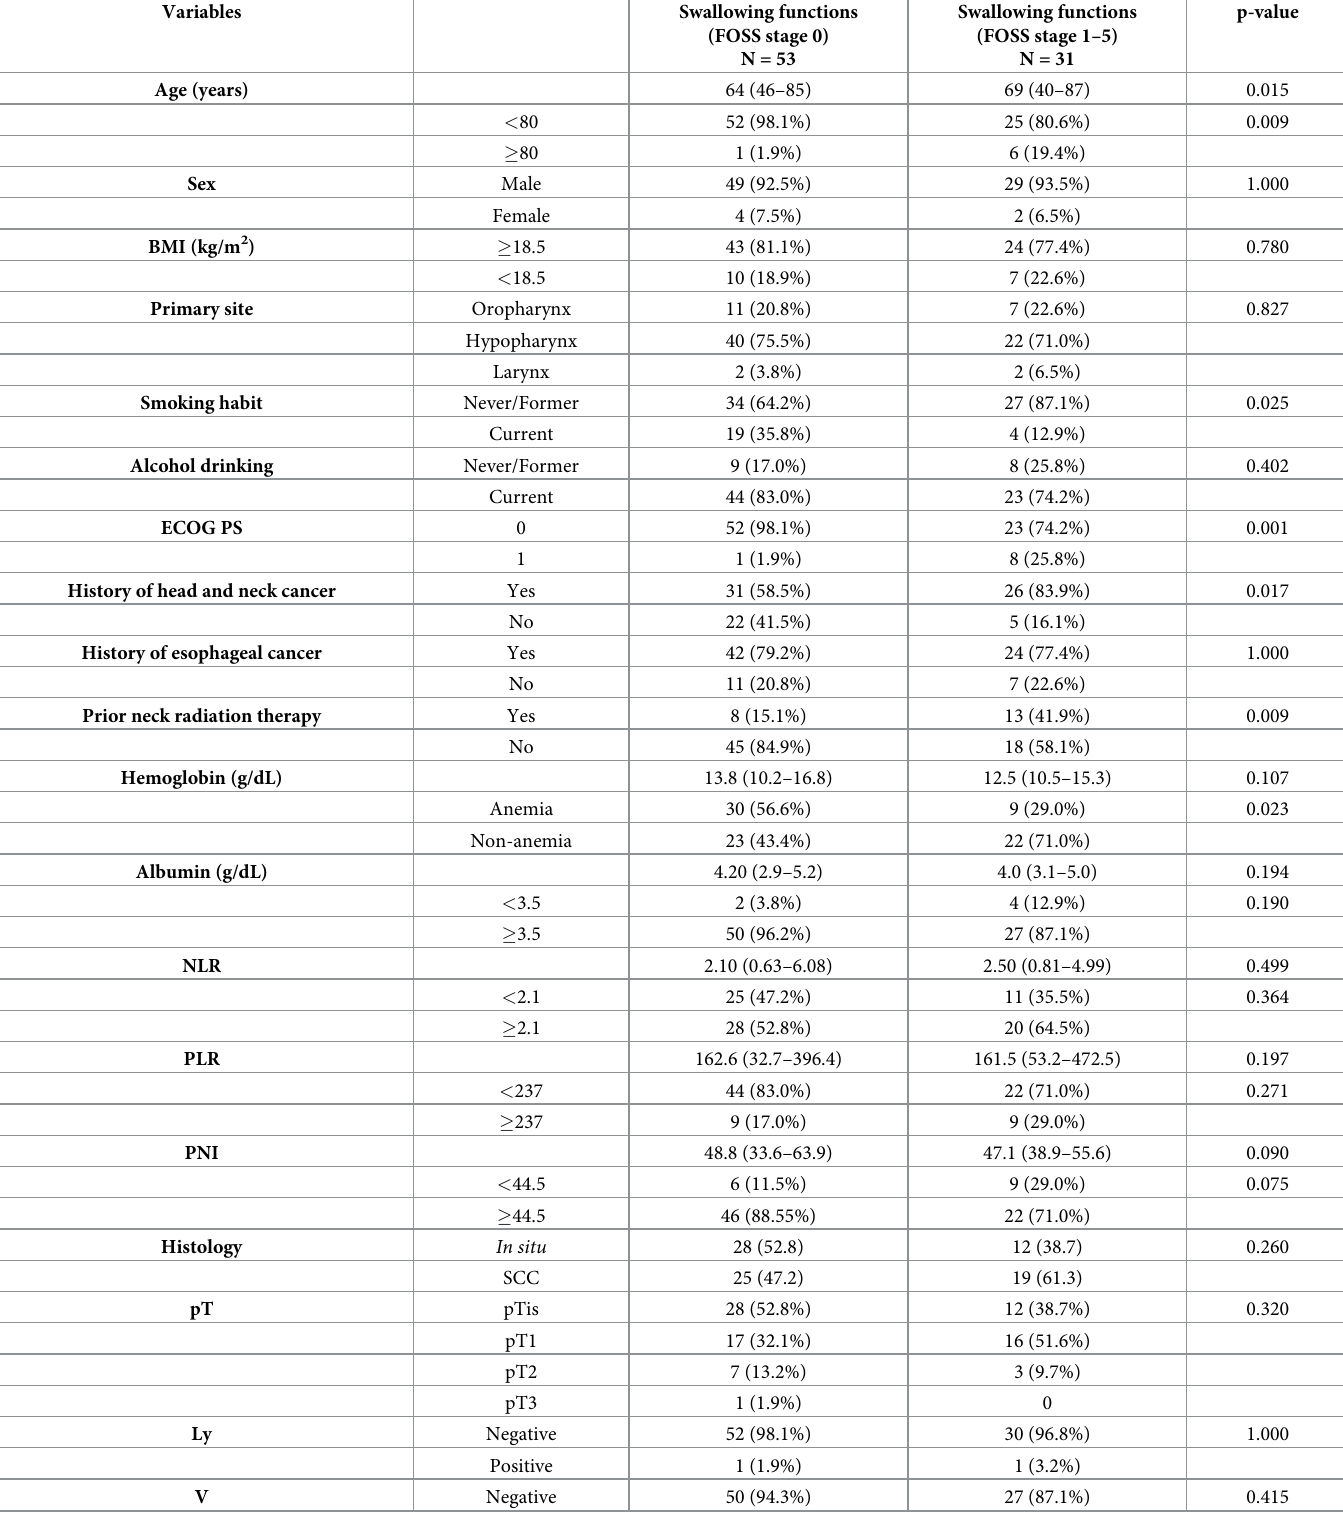
Table 2. Univariate